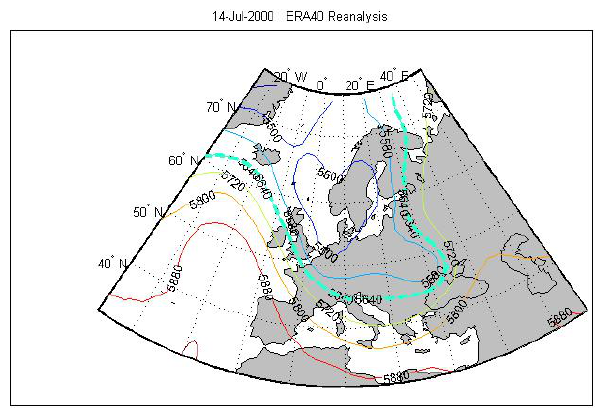
Fig.3. Frequency of occurrence of the 36 clusters.